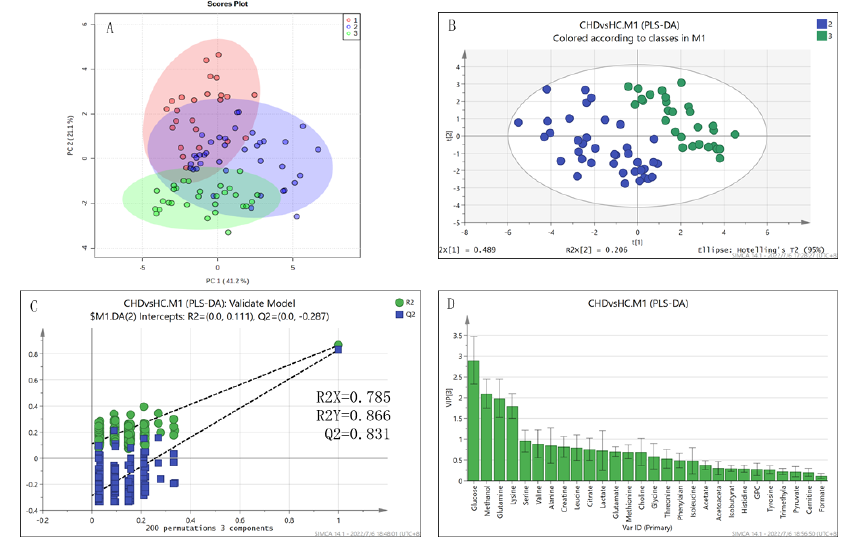
Figure 1. Multivariate statistical analysis of metabolite levels for the CHD and HC groups. ( A ) Un- supervised PCA scores plot of all samples. The PAH − CHD, CHD and HC groups of samples are marked in red, blue and green, respectively; ( B ) Supervised PLS − DA scores plot of CHD (blue) vs. HC (green); ( C ) Robustness of the PLS − DA model validated by RPTs with 200 cycles; ( D ) VIP values of metabolites calculated from the PLS − DA